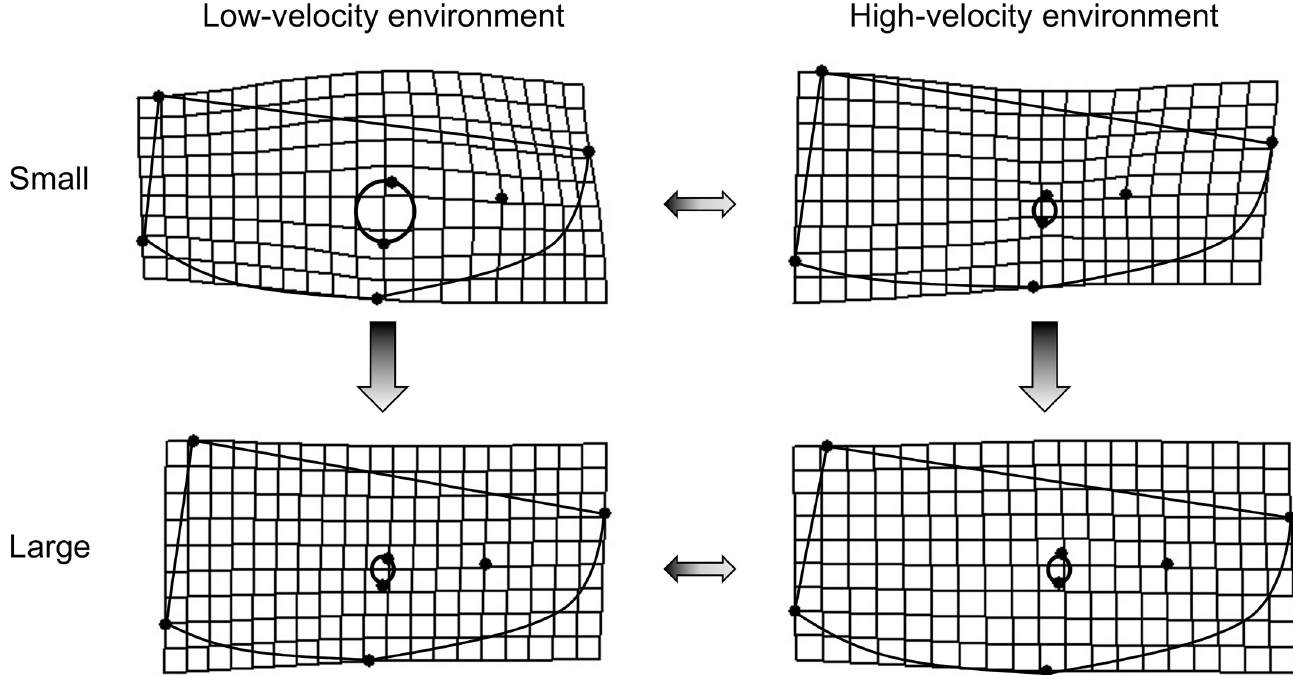
Fig 6. Visualization of variation in head shape. Thin plate spline deformations of divergence in head shape between high-velocity and low-velocity environments for large ontogenetic stage and small ontogenetic stage. Vertical arrows represent the direction of ontogenetic shape change from small to large. Horizontal arrows represent divergence between velocity